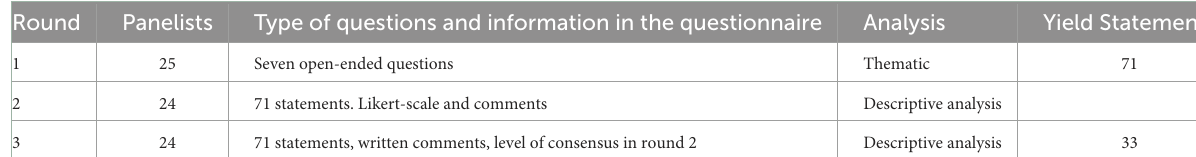
TABLE 2 The process of developing